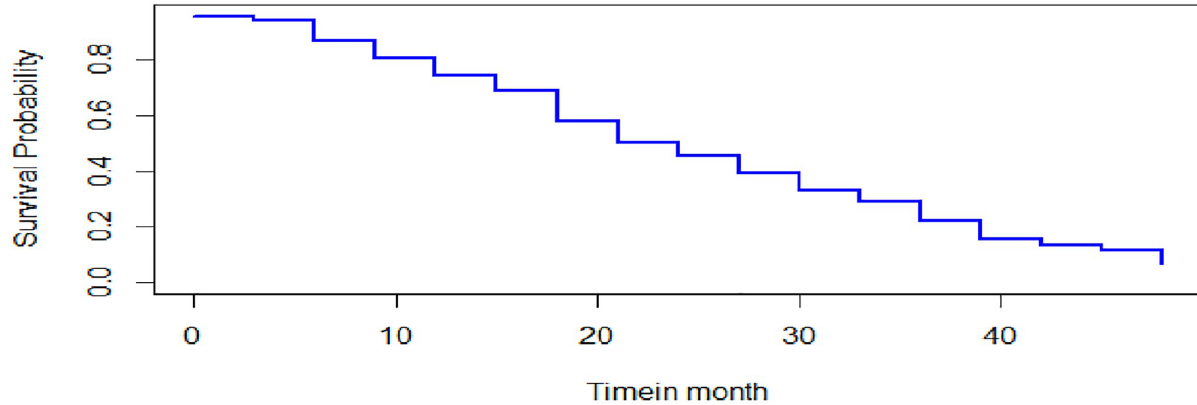
Fig 1. Overall Kaplan Meier estimate of survival